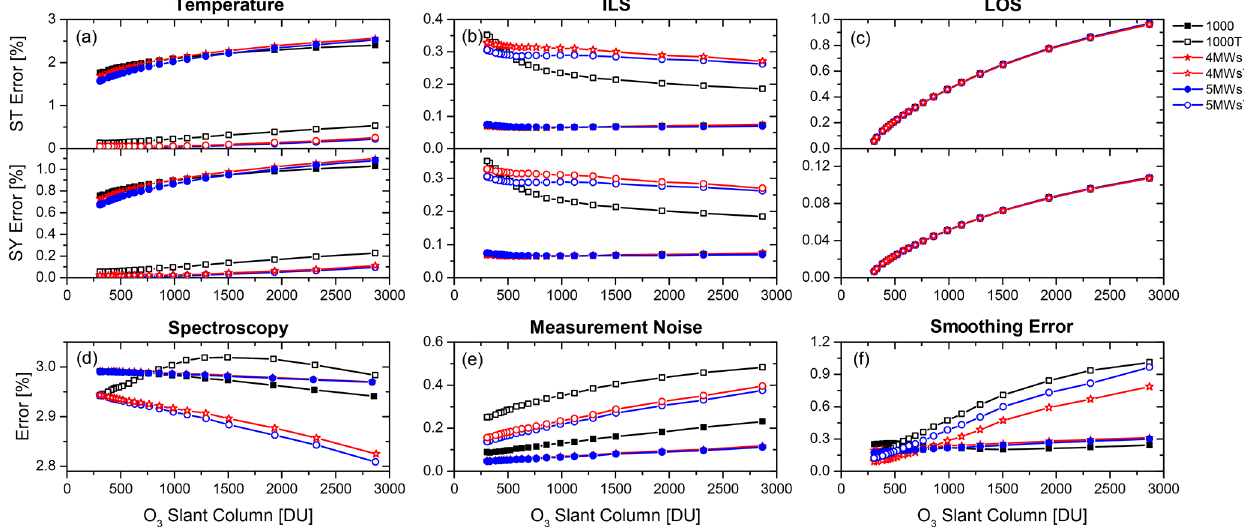
Figure B1. Estimated statistical (ST) and systematic (SY) errors (%) for O 3 TCs retrieved from all setups for different error sources ( a , atmospheric temperature profile, b , ILS function, c , LOS, d , spectroscopic parameters, e , measurement noise, and f , smoothing error) as a function of O 3 slant column (DU) for the measurements of Fig. 3.